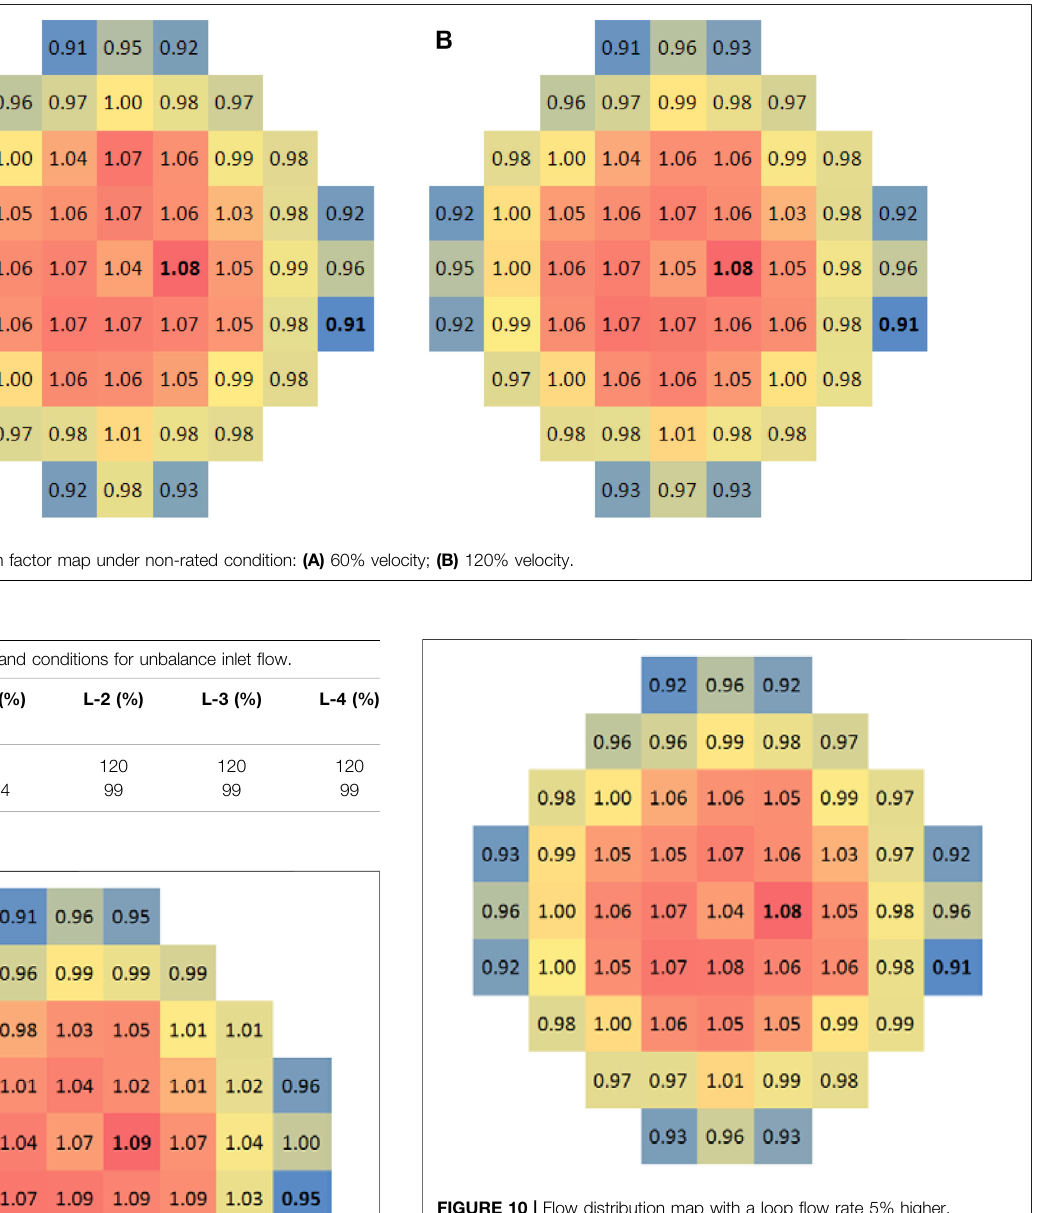
FIGURE 10 | Flow distribution map with a loop fl ow rate 5%